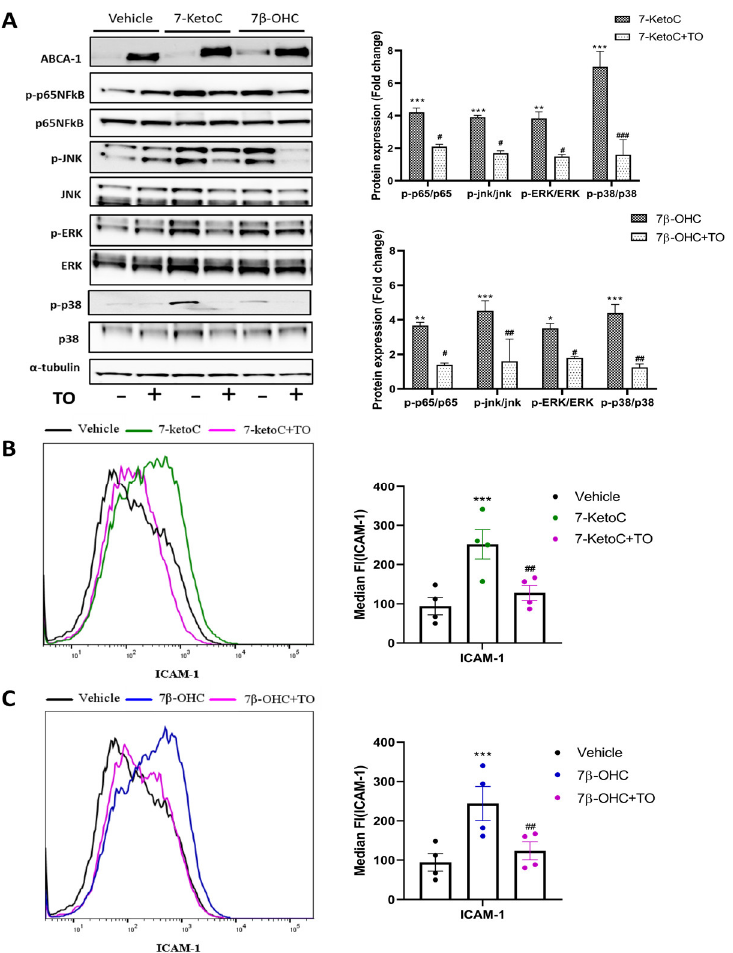
Figure 4. Synthetic LXR agonist TO reduces oxysterol-stimulated inflammatory responses in fpEC. ( A ) Representative western blot image and densitometric analysis demonstrate pronounced anti- inflammatory effects of TO in fpEC ( n = 5) treated with 7-ketoC or 7 β -OHC, confirmed by reduced phospho-p65 NF κ B and phospho-MAPK levels in the TO pre-incubated cells prior to oxysterol stimulation. Each phosphorylated protein is normalized to its respective total amount of proteins. The fold expression of the vehicle is normalized to one (not shown in the graphs). The fold change of target protein expression levels after oxysterol stimulation demonstrated is relative to the vehicle control. FACS histogram and respective median fluorescence intensity plot showing decrease in ICAM-1 cell surface expression level with TO pre-incubation followed by 7-ketoC ( B ) or 7 β -OHC ( C ) stimulation ( n = 4). Data are presented as mean ± SEM. Statistically significant differences between vehicle and oxysterol treatment (indicated with *) and between oxysterol and oxysterol + TO treatment (indicated with #) were calculated using two-way ANOVA (for phospho-proteins) and one-way ANOVA (for ICAM-1), followed by Tukey’s post hoc test. #/* p < 0.05, ##/** p < 0.01, and ###/*** p <